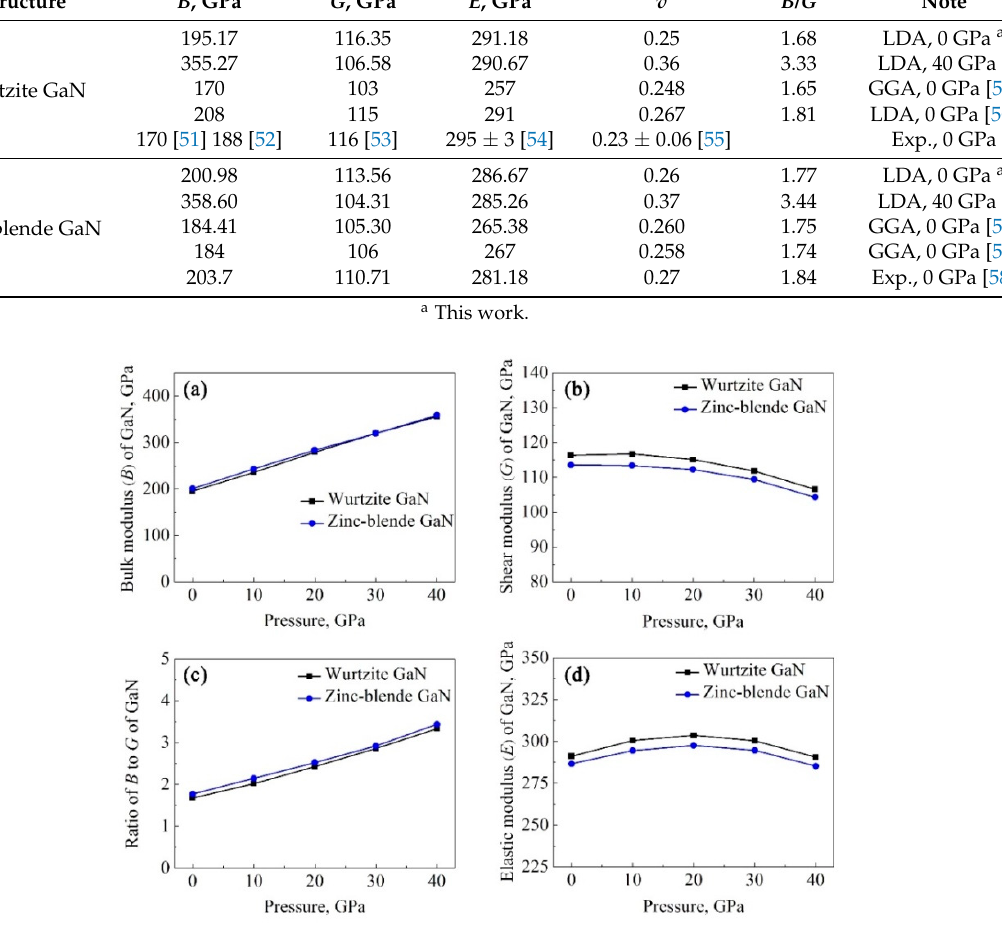
Figure 3. Hydrostatic pressure dependences of bulk modulus B ( a ), shear modulus G ( b ), B / G ( c ) and elastic modulus E ( d ) of GaN crystals.